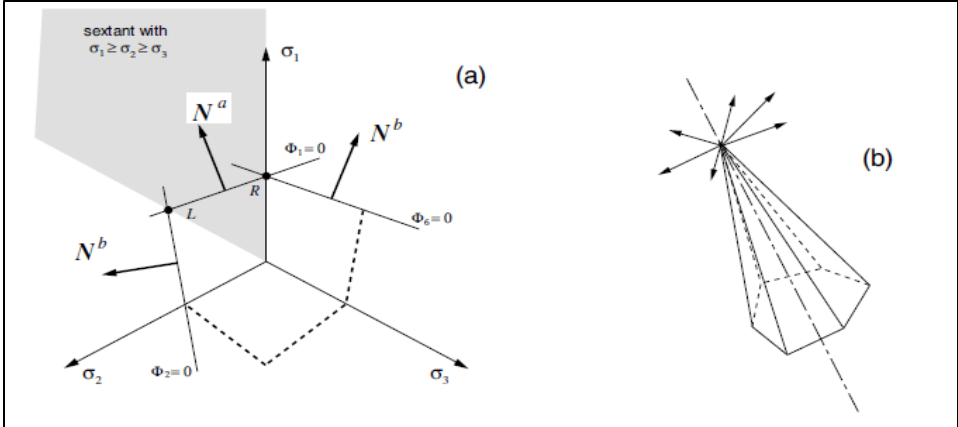
Figure 2. The Mohr–Coulomb flow rule; ( a ) faces and edges, and ( b ) apex